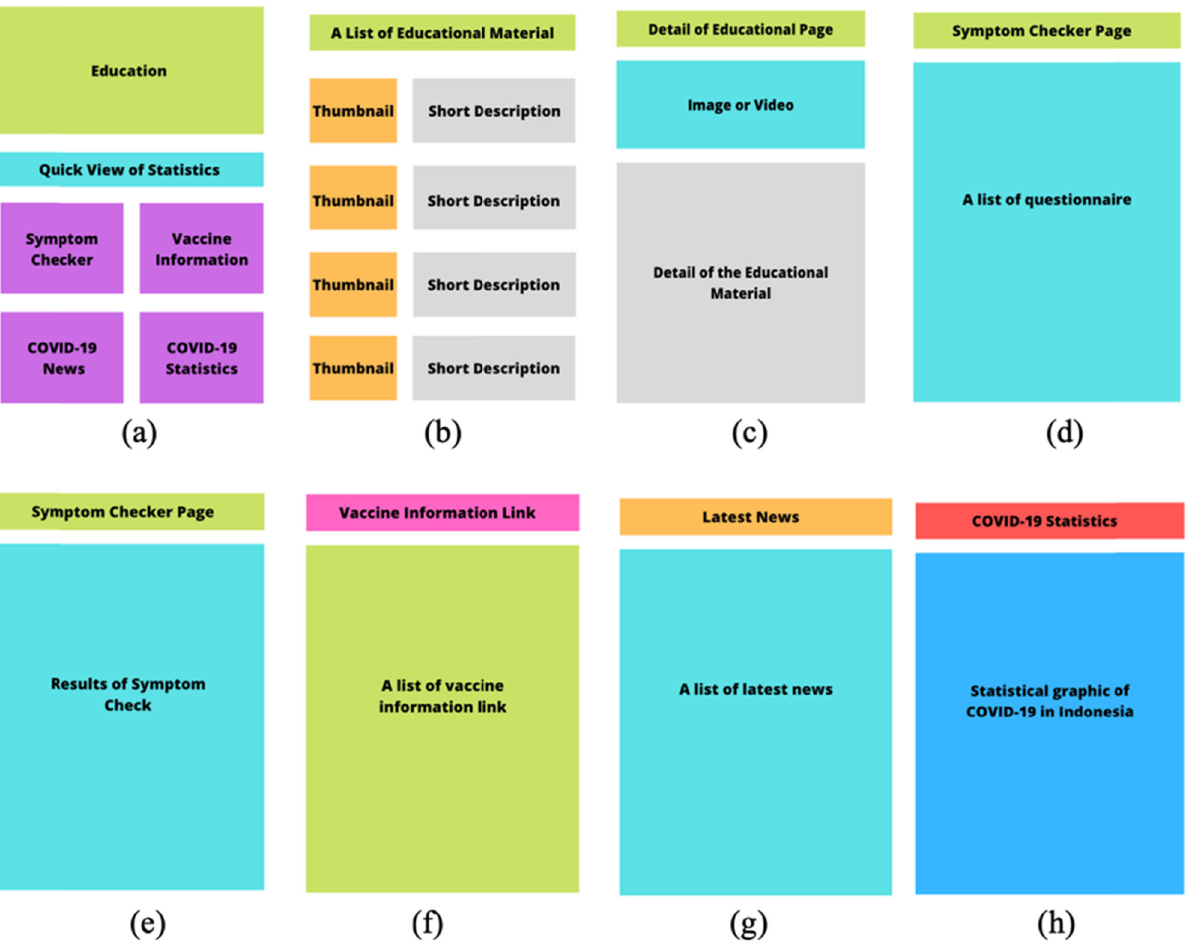
Figure 2: Initial designs of the app, including ( a ) the main menu containing many features and functions; ( b ) the list of educational materials; ( c ) the details of the educational material; ( d ) the symptom checker page; ( e ) the results of the symptom checker; ( f ) the list of vaccine information links; ( g ) the latest news on COVID - 19; and ( h ) COVID - 19 statistics.